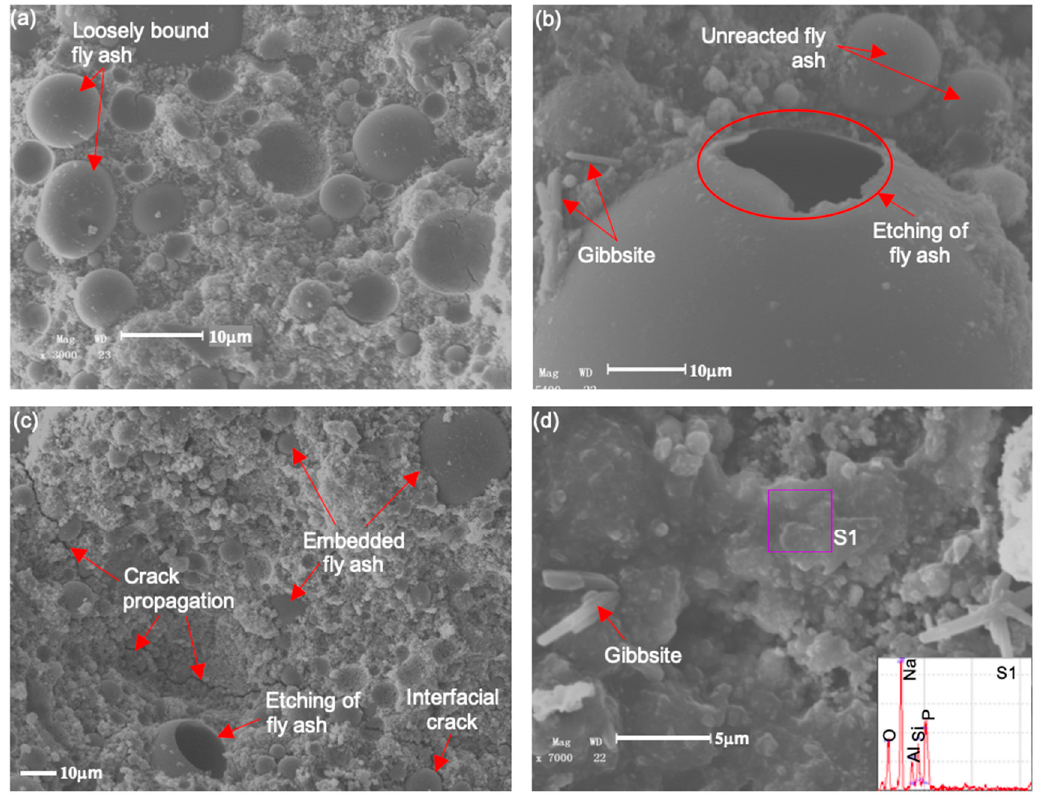
Figure 3. Microstructural characteristics of FA8 cured for ( a ) 7 days; ( b ) 14 days; ( c ) 21 days; ( d ) 28 days.